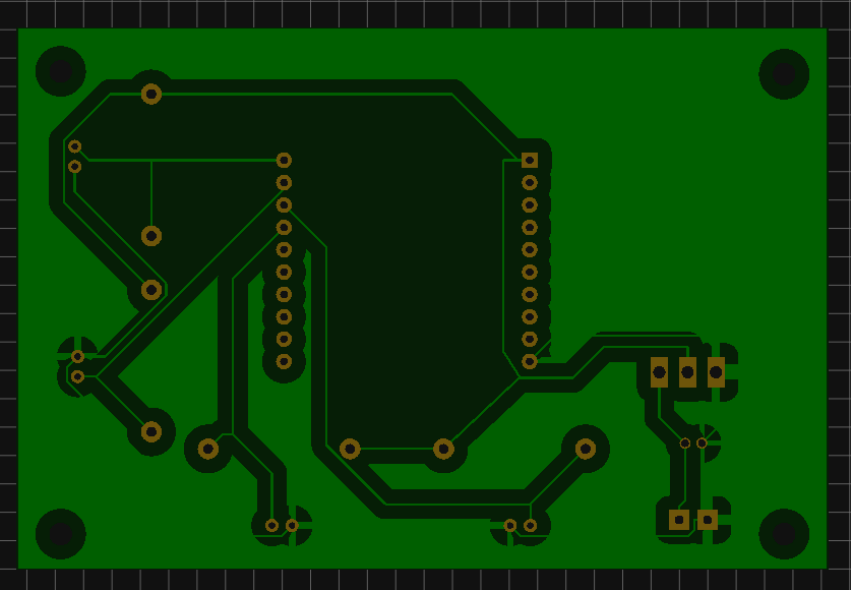
Figure 5. PCB back view from the sensor node using the